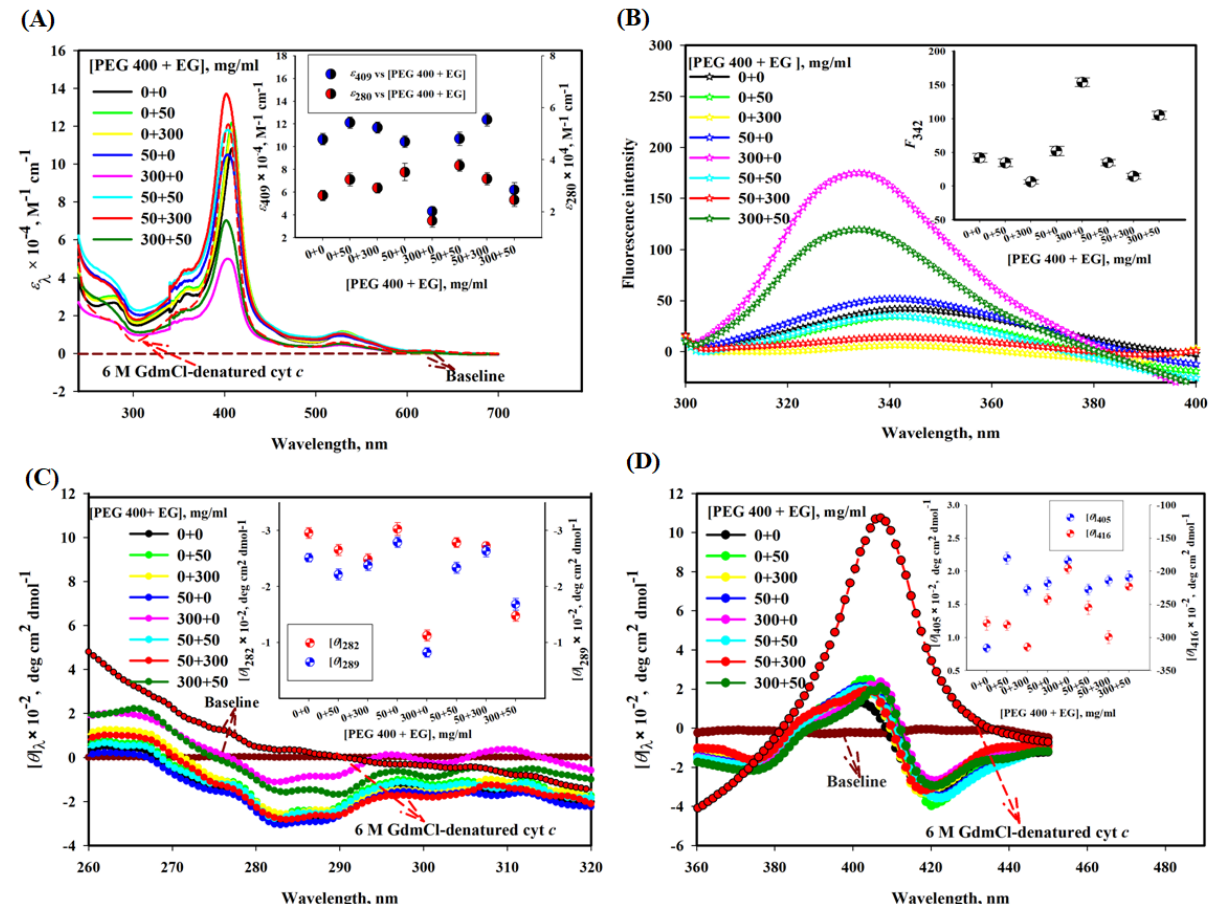
Figure 1. ( A ) Absorption, ( B ) tryptophan fluorescence, ( C ) near-UV CD and ( D ) Soret-CD spectra of cyt c with different [PEG 400 + EG] at pH 7.0 and 25 ◦ C. Inset in each figure displays a plot of ε